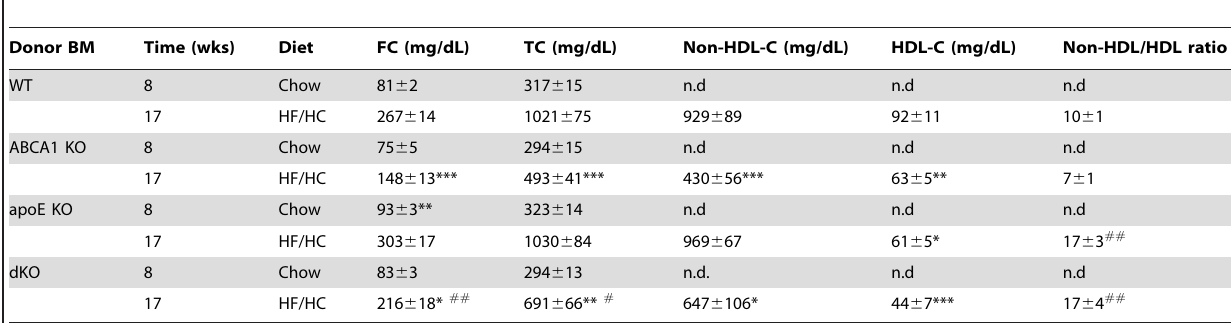
Table 1. Serum lipid and lipoprotein levels were measured at 8 weeks (chow diet) and 17 weeks (HF/HC diet) after transplantation.